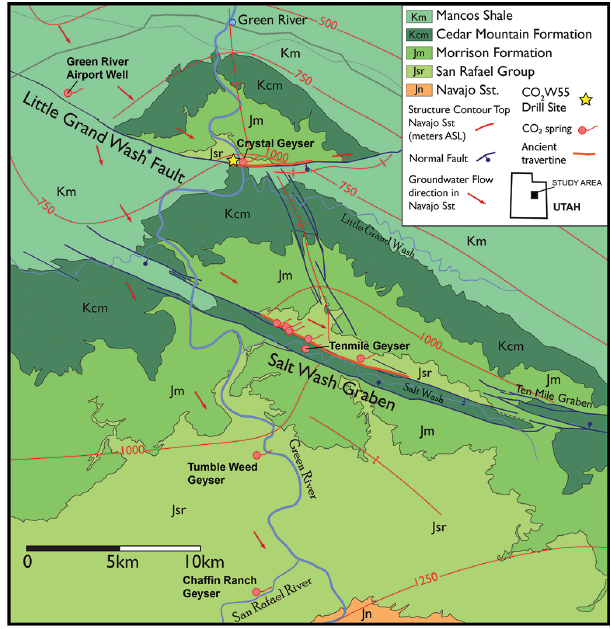
Figure 1. Geological map of the Green River anticline showing lo- cations of the Little Grand Wash and Salt Wash Graben normal fault systems, CO 2 -springs and location of drill hole CO2W55 (base map redrawn after Doelling, 2001 and Kampman et al., 2009). The distri- bution of ancient travertine mounds along the faults is highlighted, reflecting sites of paleo-CO 2 leakage (drawn from maps in Dock- rill and Shipton, 2010). Structure contours are the height of the top surface of the Navajo Sandstone above sea level, the main shallow CO 2 bearing reservoir. Groundwater flow trajectories in the Navajo Sandstone are also shown (after Hood and Patterson, 1984 and maps in Kampman et al., 2009). Meteoric fluid flows from recharge zones in the San Rafael Swell to the northwest to zones of discharge in the Green River. The CO 2 and CO 2 -charged brine flowing up the faults, mix with meteoric fluids in the Navajo Sandstone and flow parallel to the faults where they are sealing, and to the south-east where they are transmissive, being driven by the regional gradient in groundwa- ter